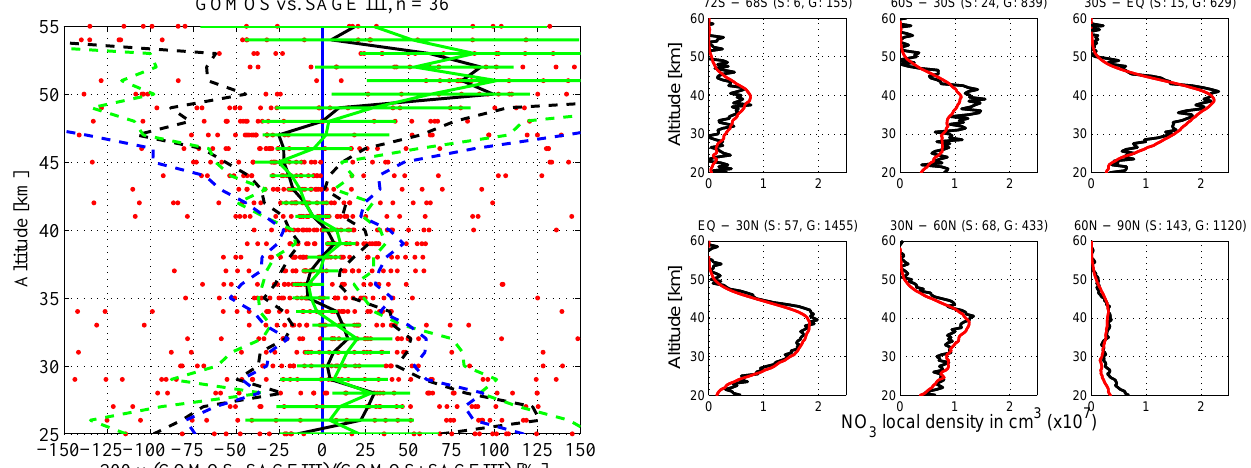
Fig. 7. GOMOS (red) and SAGE III (black) zonal medians in six different latitude bands in 2004. The zonal medians are calculated from three month periods where the spatial and temporal distribu- tions of the measurements inside the latitude band are closest. For latitude band 90 ◦ S–60 ◦ S, the median is calculated only from one month period (October). The numbers after S and G in titles indicate from how many profiles the median was calculated for SAGE III and GOMOS,